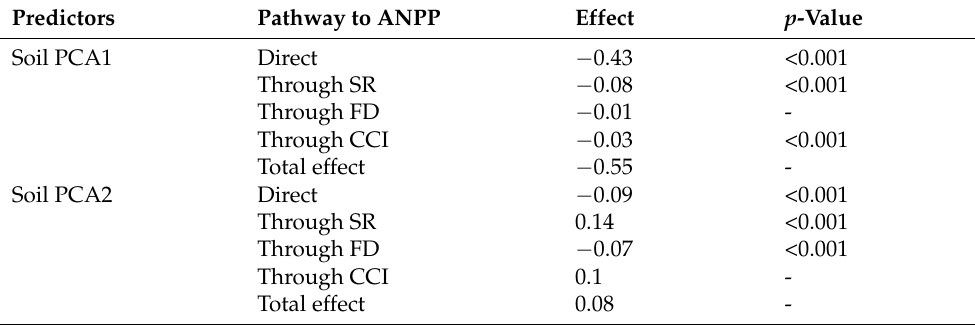
Figure 4. Bivariate relationships between endogenous and exogenous variables (n = 44). The scatter plots ( a – d ), ( e – h ), ( i – l ) and ( m – p ) capture the relationships between species richness (SR), functional diversity (FD), crown complementarity index (CCI), annual forest productivity (ANPP), soil organic carbon (TOC), total nitrogen content (TN), total phosphorus content (TP) and soil bulk density (BD). The R 2 and p -values are shown. All numerical variables are natural log-transformed. Table 2. The direct, indirect and total standardized effects on ANPP based on structural equation models